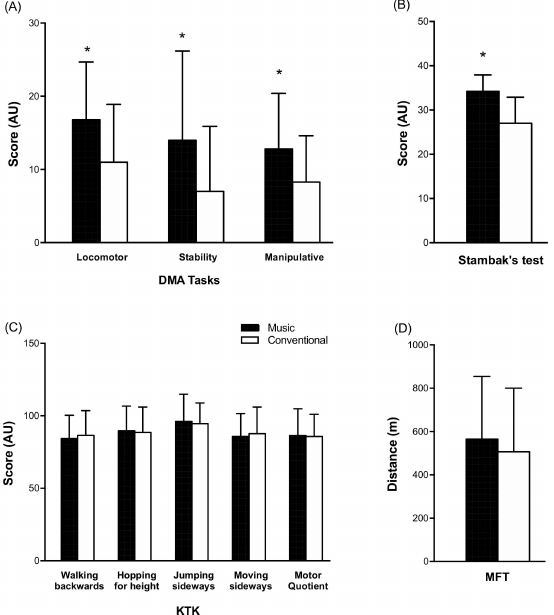
Figure 4. The main effect of the education plan on the measured variables. ( A ) Divergent Movement Ability tasks. ( B ) Stambak’s Test. ( C ) Körperkoordinationstest Für Kinder. ( D ) Multistage Fitness Test. * = different than conventional ( p <